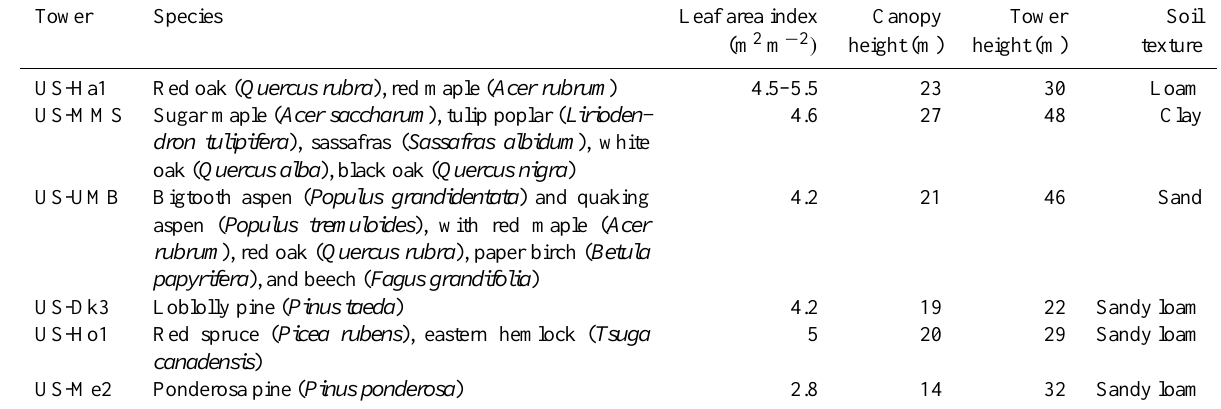
US-Dk3 Loblolly pine ( Pinus taeda ) US-Ho1 Red spruce ( Picea rubens ), eastern hemlock ( Tsuga canadensis ) US-Me2 Ponderosa pine ( Pinus ponderosa